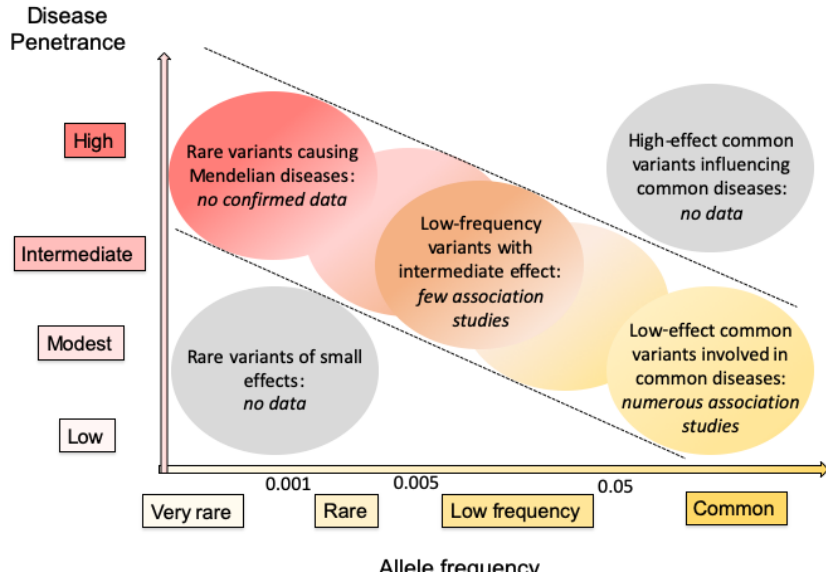
Figure 3. Current knowledge of variants in genes encoding human EHs based on allele frequency and disease penetrance. The disease penetrance is dependent on the strength of the variant genetic effect. Rare variants of small effects are hard to identify through genetic means, and are of low interest when investigating the pathophysiology of diseases. High-effect common variants influencing common diseases are very rare among human disorders. Consequently, most interest lies in genes shown within diagonal dotted lines. The data obtained to date for genes encoding human EHs are summarized in italics. This figure is based on concepts presented in two previous general reports on human genetics [95,96].